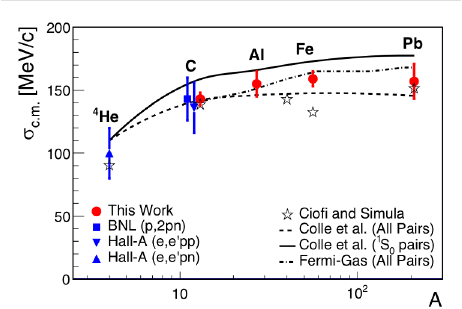
Figure 5. The width of the c.m. momentum distribution for SRC pairs as a function of nuclear mass. The red full circles show data points obtained in this work. These data agree with the previous mea- surements [12–14] (blue full squares and triangles). Theoretical calculations by Ciofi degli Atti and Simula [16] are shown as open stars, Colle et al. [15] considering all nucleon pairs as a dashed line, and only 1 S 0 pairs as a solid line. Calculations for SRC formation from the Fermi-gas is shown as a semi-dashed line. Figure is adapted from